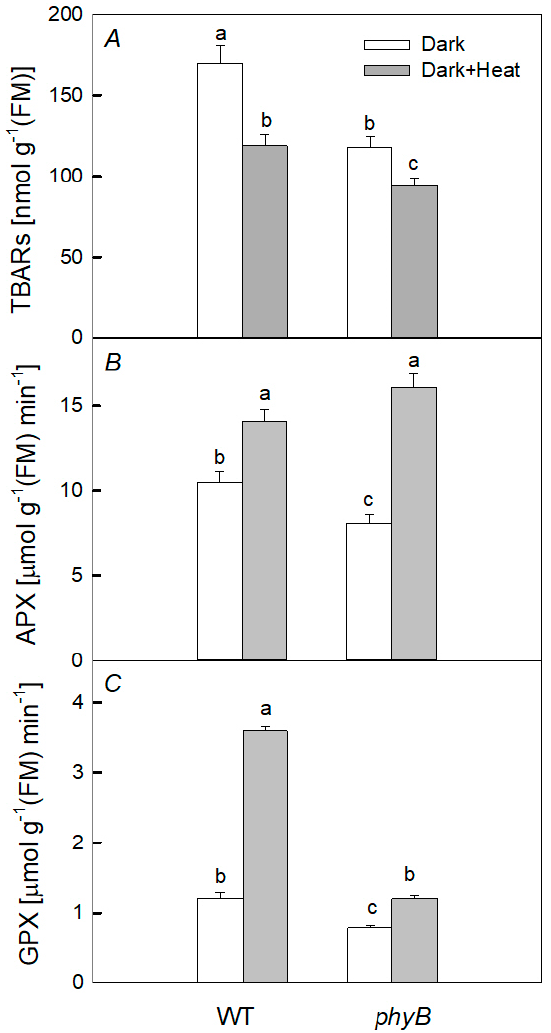
Figure 5. Effect of 6 h heat treatment (40 °C, dark) on the activity of the antioxidant enzymes ascorbate peroxidase (APX) ( B ) and guaiacol-dependent peroxidase (GPX) ( C ), as well as the content of thiobarbituric acid reactive substances (TBARs) ( A ) in the leaves of WT and phyB mutant plants. Mean values ± SD are shown ( n = 4). Different letters correspond to a significant difference in values at p < 0.05.